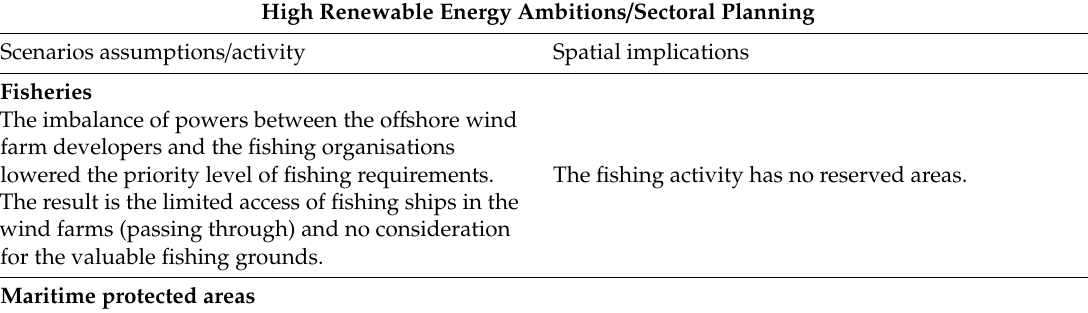
Table 12. Scenario D: High renewable energy ambitions / sectoral